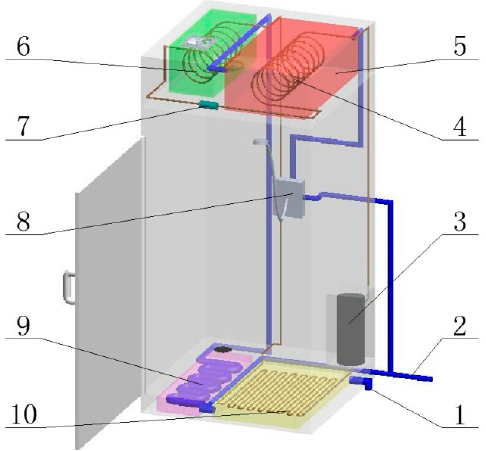
Figure 1. Schematic diagram of the bathroom unit: 1—Wastewater outlet; 2—Tap water inlet; 3—